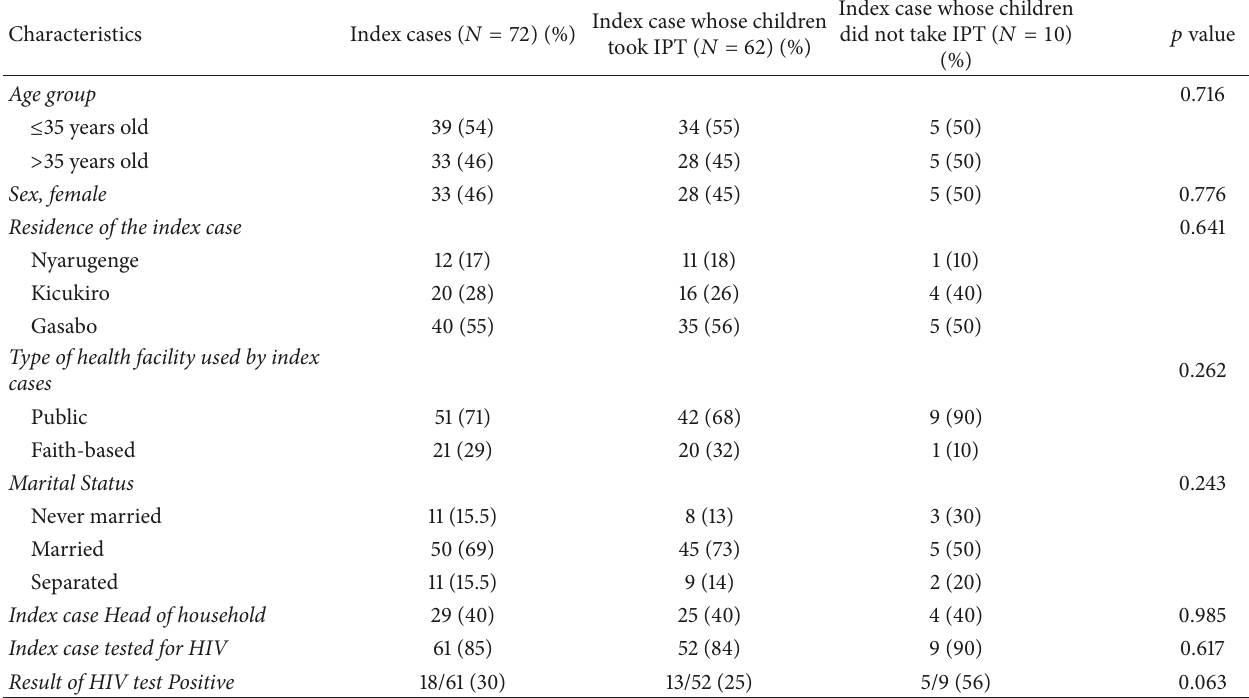
Table 1: Characteristics of the index cases of the child contacts by uptake of